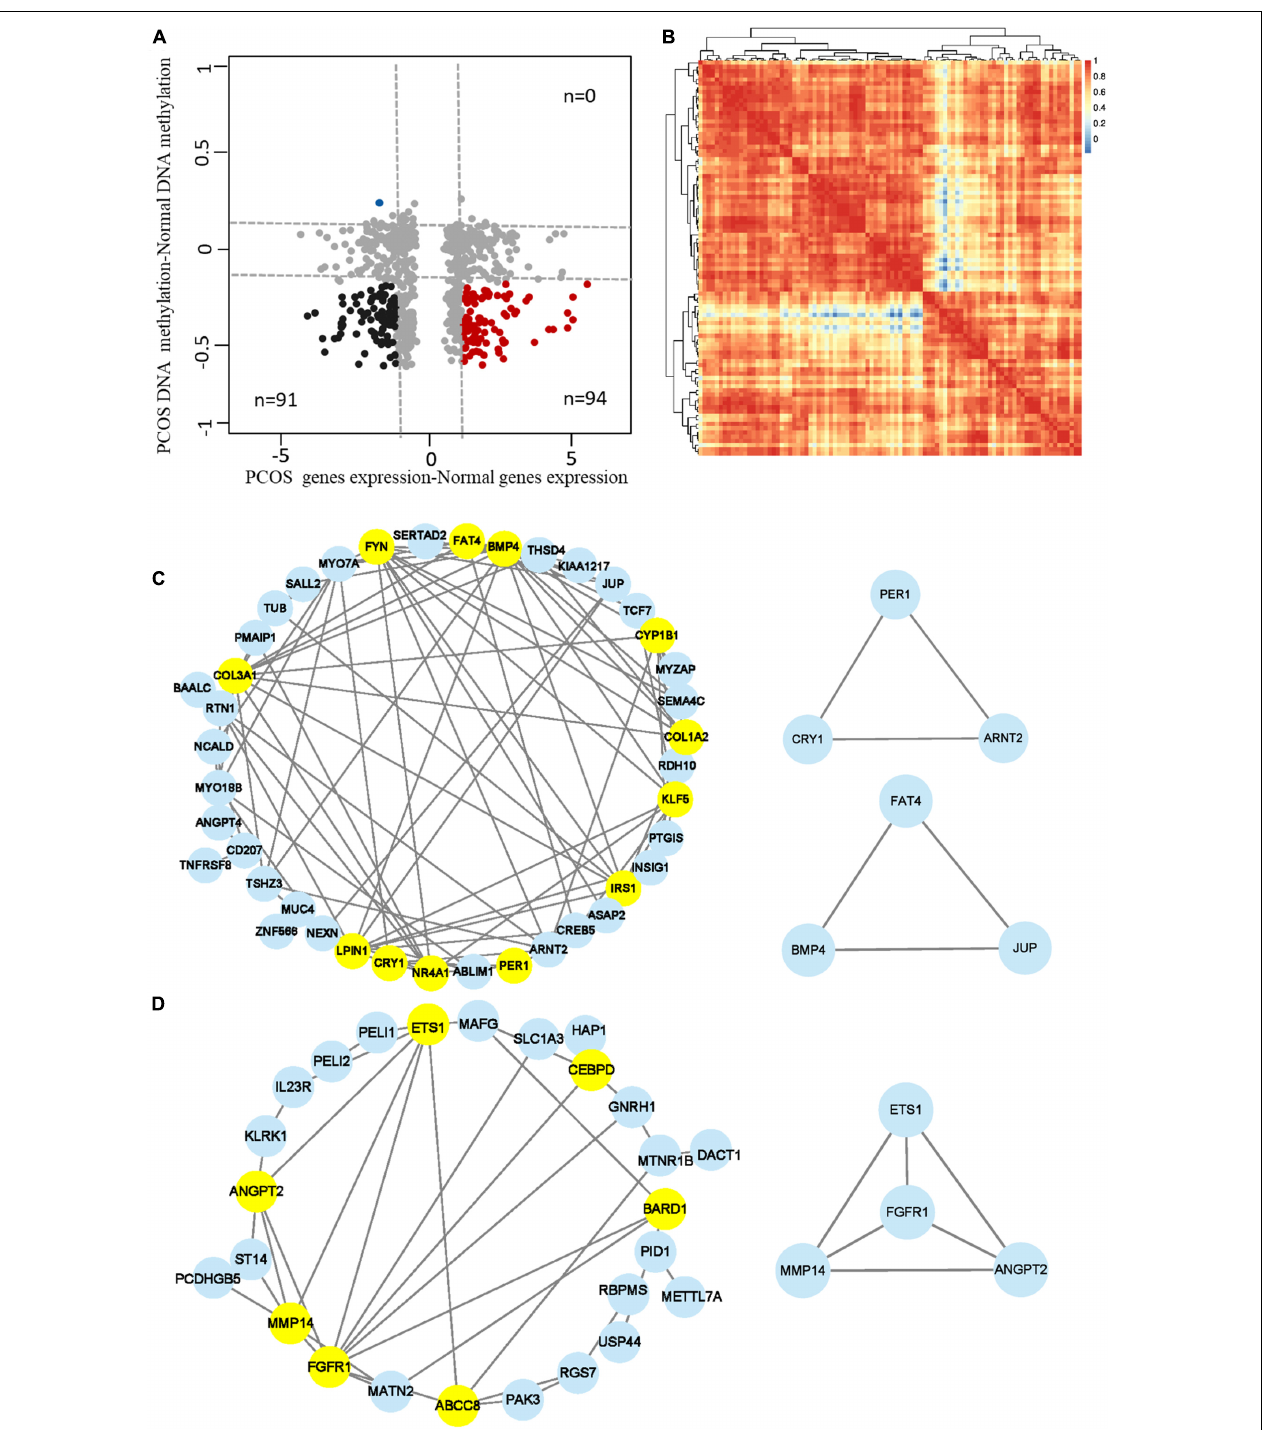
FIGURE 4 | Identification of the hub methylation marker genes in PCOS. (A) Scatterplots showing the comparison between transcriptome and the DNA methylome. Genes with significant changes in DNA methylation levels (abs change > 0.2) and expression levels (abs log2 fold change > 1) were defined as “methylation-affected genes.” Hypermethylation-affected downregulated genes were labeled in blue; Hypomethylation-affected upregulated genes were labeled in red. (B) Heatmap showing the module clustering of 94 methylation-affected upregulated genes by Pearson correlation coefficient. (C,D) Network diagrams showing interaction of genes in the two modules that were obtained in panel (B) . Hub node genes were highlighted by yellow. The genes in the small networks are highly connected in the networks calculated by module mining.